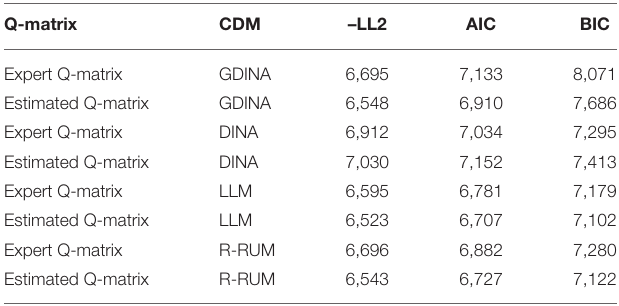
TABLE 7 | Fit results for the fraction subtraction data using the expert and estimated Q-matrix.